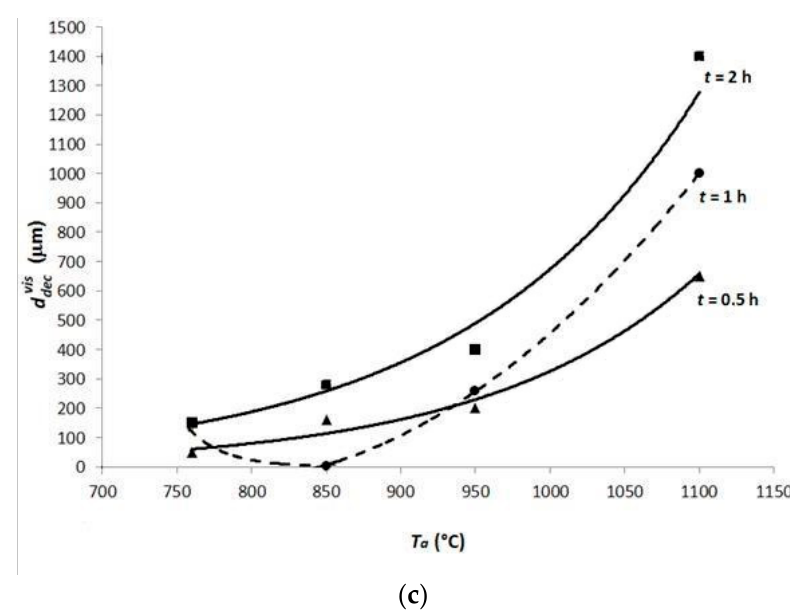
Figure 10. Visible thickness of decarburization for steel with C = 0.43 wt %. ( a ) Maximum thicknesses related to annealing time, ( b ) maximum thicknesses of surface ferrite layer related to annealing time, ( c ) maximum thicknesses related to temperature.